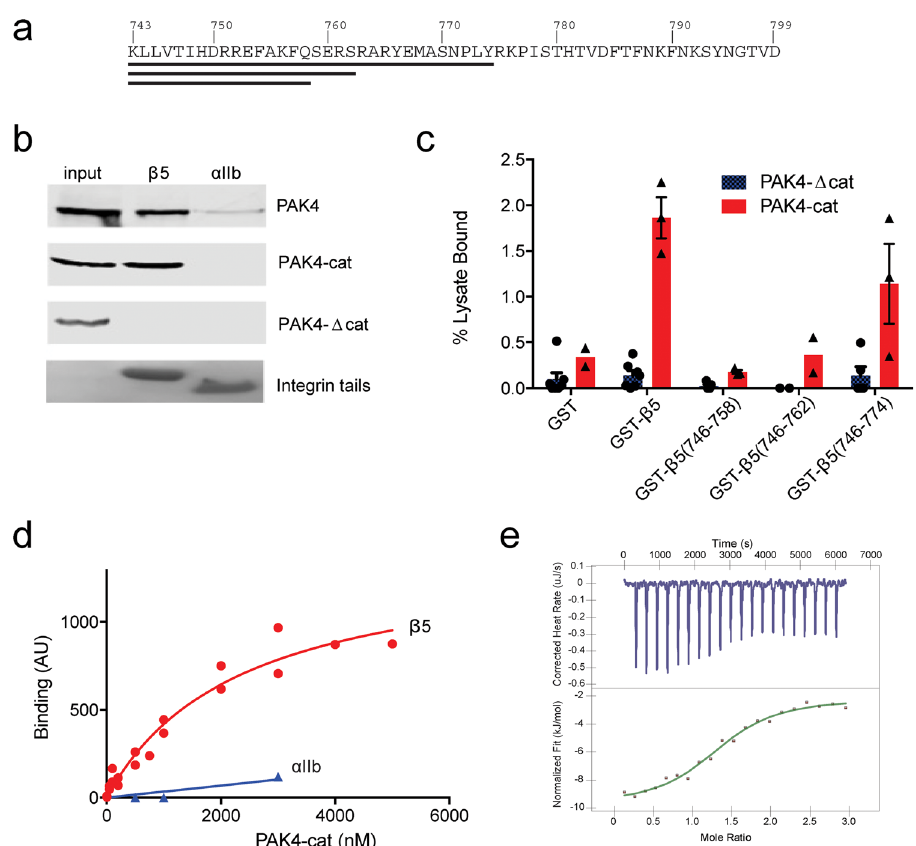
Fig. 1 PAK4 interacts speci fi cally with integrin β 5. a Sequence of the integrin β 5 cytoplasmic tail. Black lines indicate truncated constructs. b Pull down of overexpressed GFP-PAK4 constructs by nickel bead bound integrin cytoplasmic tails. Pull-down is followed by immunoblotting with anti-GFP antibodies. 3% of input lysate shown in input lane. Tail loading is assessed by Coomassie staining. c Mapping PAK4-binding site in integrin β 5 tails. Quanti fi cation of pull-down assays for GFP-PAK4- Δ cat or GFP-PAK4-cat binding to GST, or GST β 5 truncations. Error bars indicate SEM. d Apparent af fi nity of PAK4 kinase domain for integrin β 5 cytoplasmic tail compared to control integrin α IIb cytoplasmic tail. Results from three independent experiments were fi t to a one-site speci fi c-binding model in Prism. e Example isotherm for β 5 cytoplasmic tail titrated into PAK4 kinase domain. Source data are provided as a Source Data fi